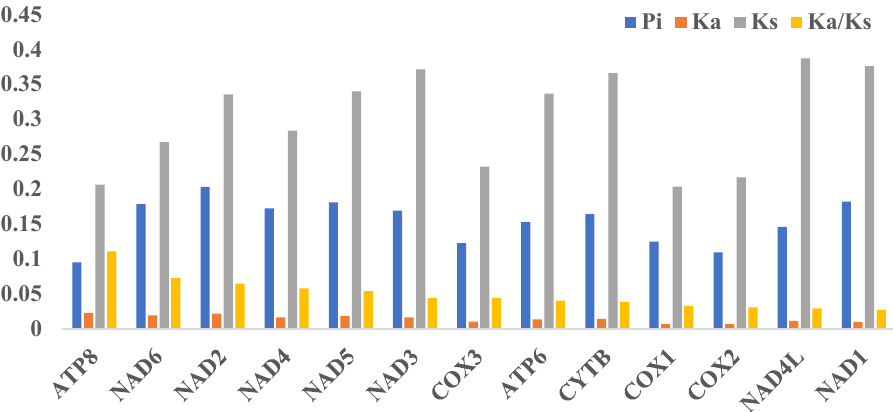
Figure 2. Genetic diversity and the Ka/Ks ratio of each PCG among the Triplophysa mitogenome. The aligned sequences of 13 PCGs of six Triplophysa mitogenomes were used to detect DNA polymorphism (Figure 2, Supplementary Table S2). The highest nucleotide diversity (Pi) was found in the nad2 gene (0.203), followed by nad1 (0.182), nad5 (0.181), and nad6 (0.178). The cox3 (0.134), cox1 (0.130), and nad1 genes (0.129) have the lowest values. A similar pattern was also observed in terms of mean genetic distances (Table S3 in the Supplementary Materials). Nad2 , nad11 , nad5 , and nad6 genes showed high genetic distances with 0.24, 021, 0.21, and 0.21, whereas the cox3 , cox2 , and atp8 genes exhibit lower genetic distances of 0.14, 0.12, and 0.10, respectively. 3.3. Sequence Divergence within T. bombifrons Mitogenomes Comparing the two mitogenomes of T. bombifrons between our study and the previous report (NC_027189), 4.14% nucleotide dissimilarity (677 SNPs and 9 INDELs) had been found (Table S1 in the Supplementary Materials) [17] . In total, 550 SNPs were distributed widely among the 13 PCGs, the nad5 gene (1839 bp) demonstrated a higher ratio (12.34%) than other PCGs relative to the size of the gene, whereas the atp6 gene (684 bp) had the lowest ratio (0.58%). A similar result has been reported in Branchinella kugenumaensis mitogenomes, indicating that sequence divergence within the same species is a common phenomenon [20]. The similarity patterns of amino acid composition and synonymous codon usage were found in two T. bombifrons mitogenome sequences (Figure 3 and Supplementary Figure S1 in the Supplementary Materials). The analysis of RSCU showed that the 13 PGCs contain all codons. The five most frequently used codons in our study were Met (AUA), Met2 (AUG), Ala (GCC), Leu (CUU), and Thr (ACC), while in a previous report (NC_027189), they were Met (AUA), Met2 (AUG), Ala (GCC), Leu (CUU), and Ter (UAA) [17] . 3.4. Phylogenetic Analyses To ensure the reliability of the phylogenetic analyses, we downloaded all 28 mitogenomes of the Triplophysa species that have been characterized to date (28 October 2022) from the NCBI reference sequence (RefSeq) database [42]. The ML analyses showed Triplophysa contains 4 main clades (Clades I, II, III, and IV) (Figure 4). Clade I is divided into two subclades (I-A and I-B), with strong support in our phylogenetic reconstructions. The phylogenetic position of T. bombifrons indicated that it is the closest species to T. tenuis in subclade I-A, which was not reported in the previous T. bombifrons mitogenome report